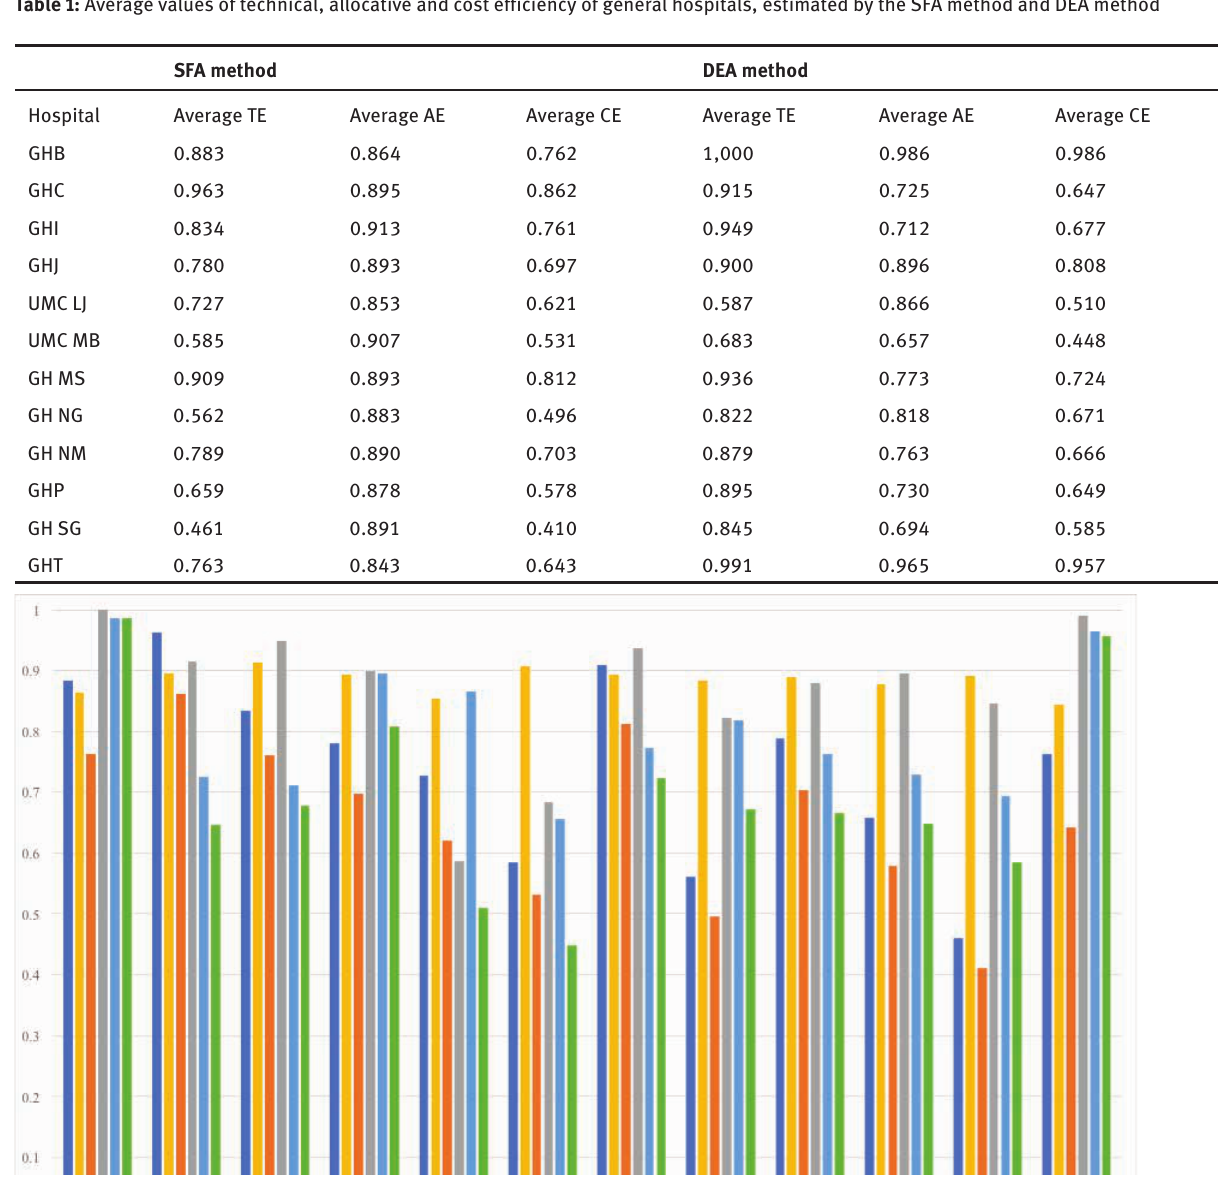
Figure 1: Average values of technical, allocative and cost efficiency of general hospitals, estimated by the SFA method and DEA method